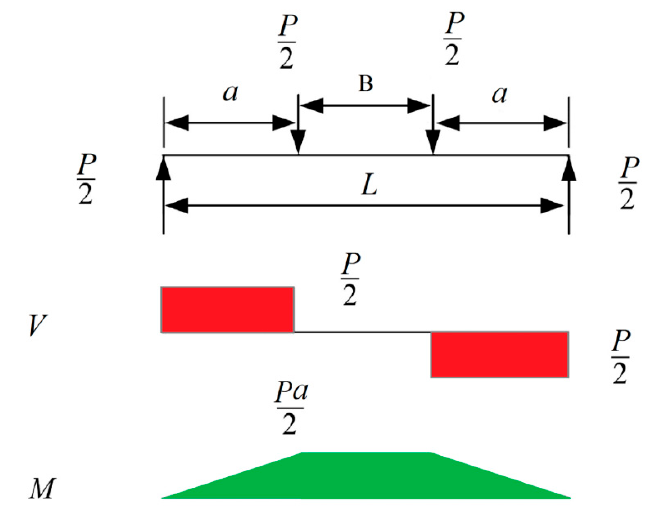
Figure 10. Typical load distribution for a four-point loading set-up.